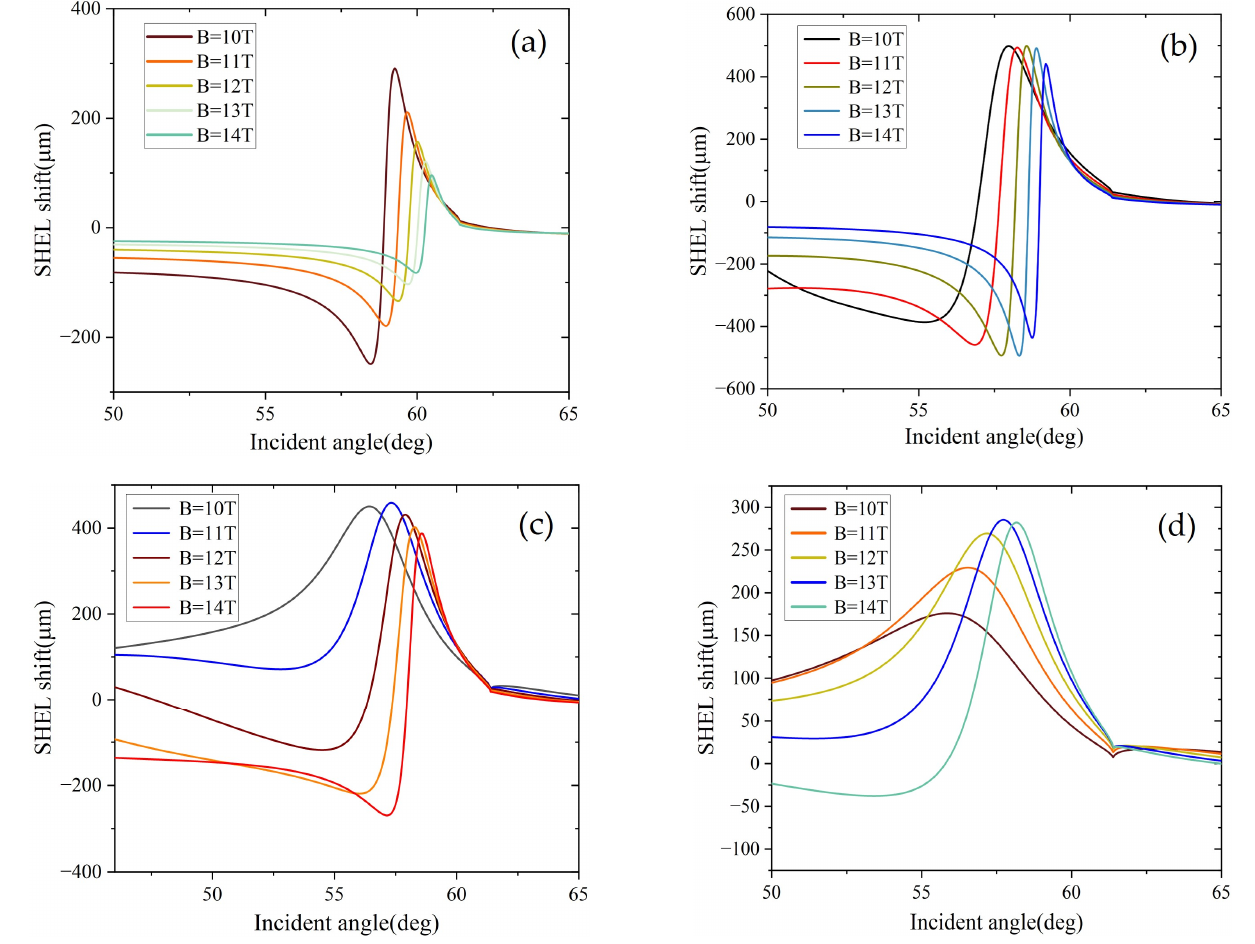
Figure 6. At different Fermi levels ( E f ), variation of the beam centroid displacement of SHEL